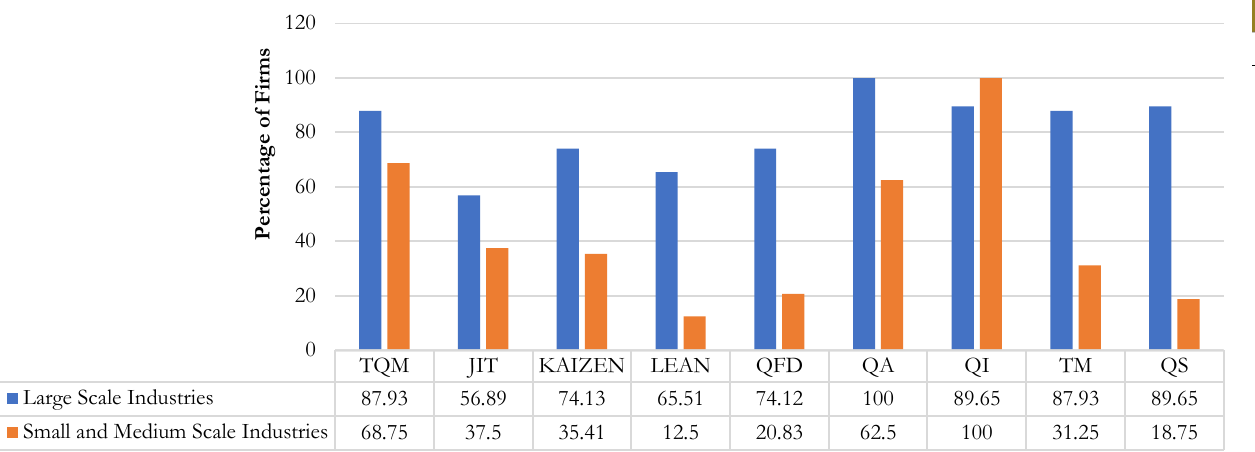
Fig. 2. Comparison of quality initiatives between large and small-medium scale firms.